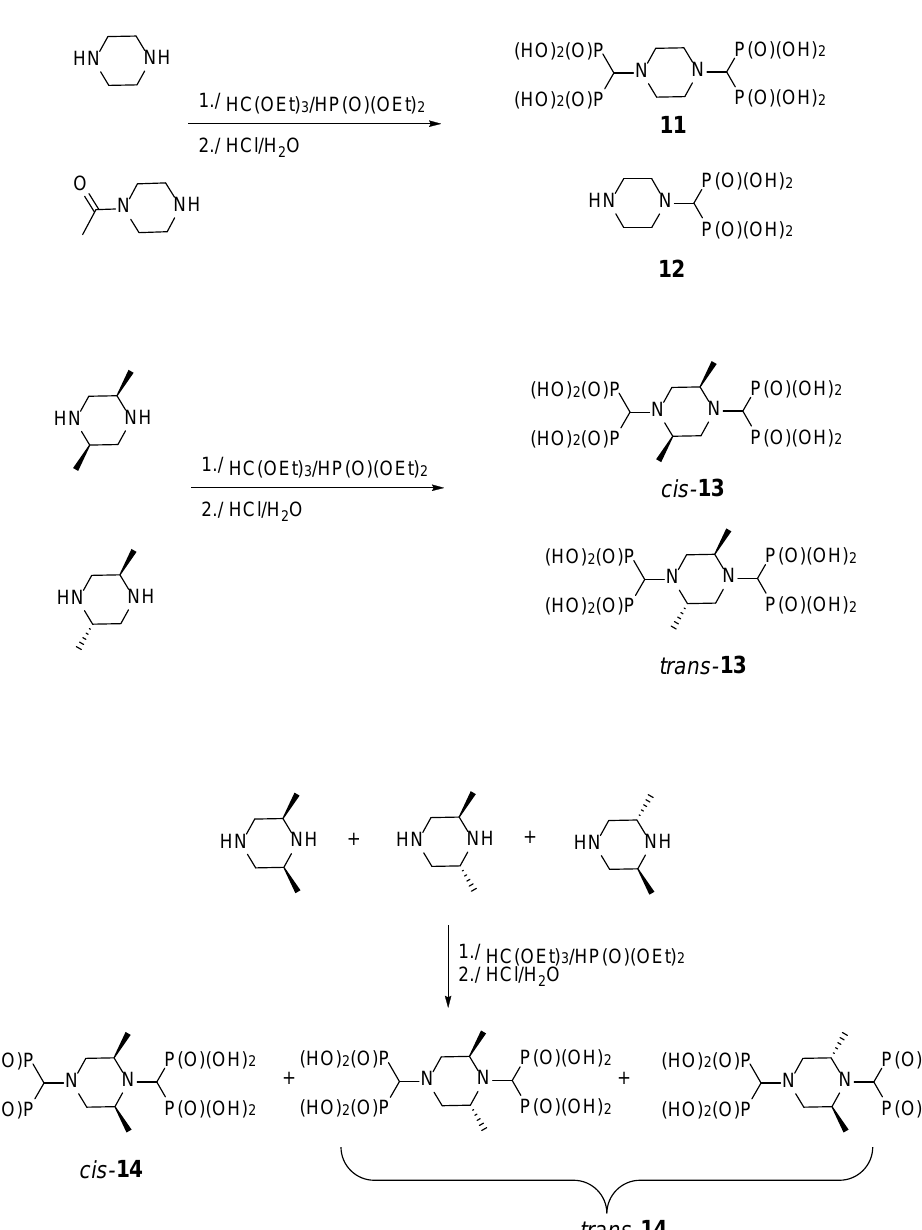
Figure 7. Products of the three-component reaction of piperazines, triethyl orthoformate, and diethyl phosphite.